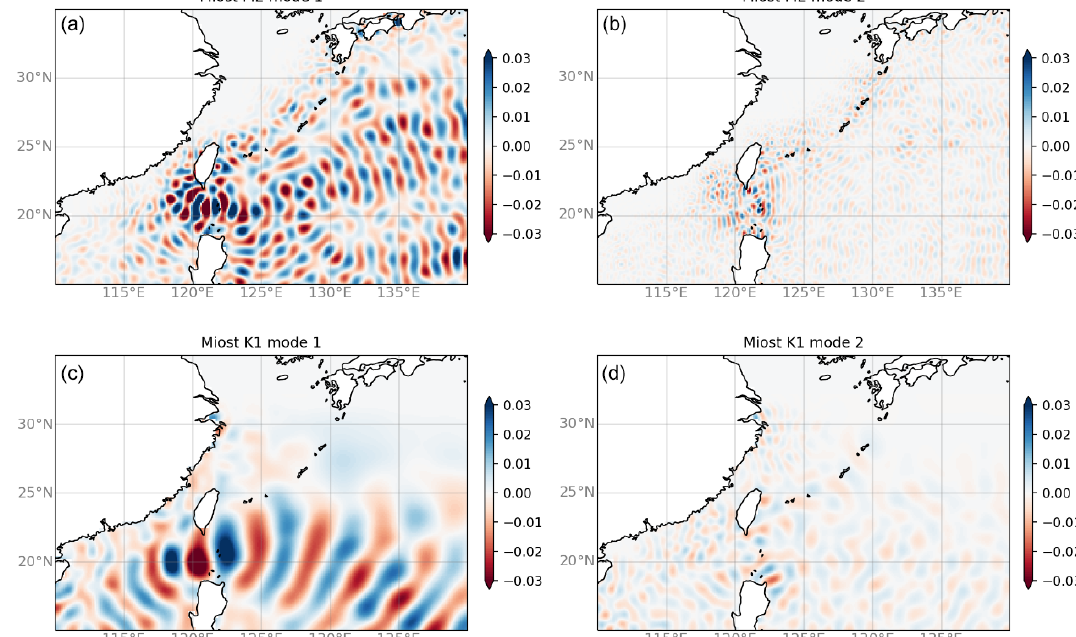
Figure 7. Snapshots of the reconstructed internal tide solutions in the Philippine Sea for M2 (a, b) and K1 (c, d) , for the mode-1 contribution (a, c) and the mode-2 contribution (b, d)